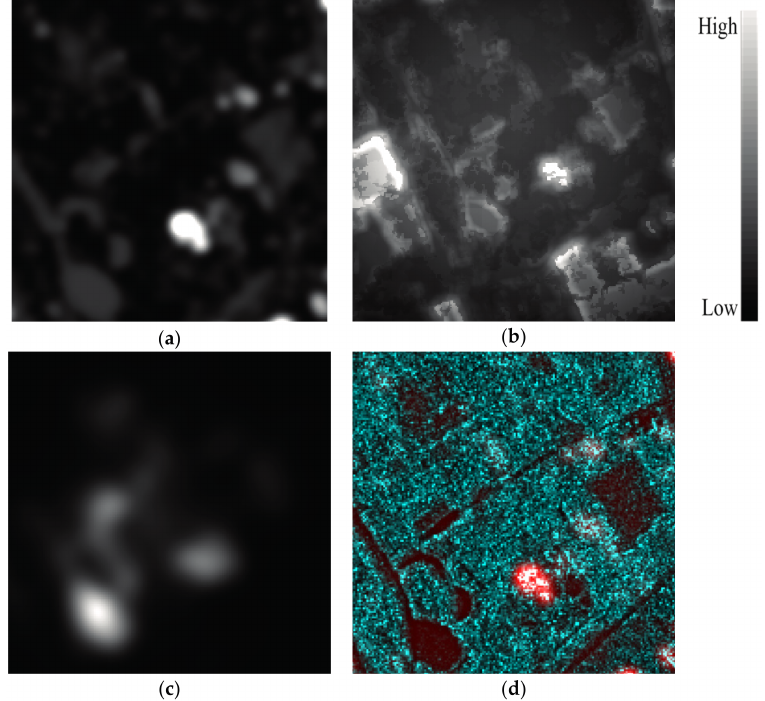
Figure 9. Saliency map generation results of Radarsat-2 C-band data with uniform background. ( a ) The proposed method; ( b ) The SDPolSAR method; ( c ) The PRSaliency method; ( d ) Span image overlaid with the saliency map of ( a ), where the red regions are